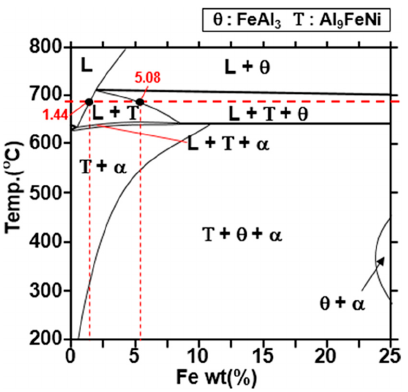
Figure 11. Part of the (Al–7Ni)– x Fe quasi-binary phase diagram calculated using